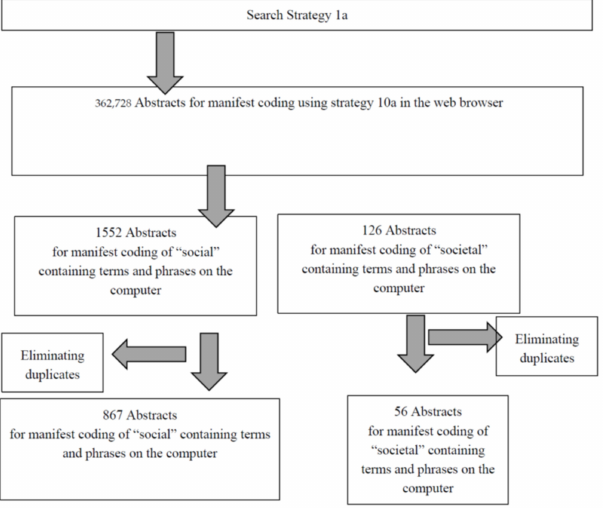
Figure 3. Search strategies for obtaining abstracts for manifest coding for the technical quantum terms in the